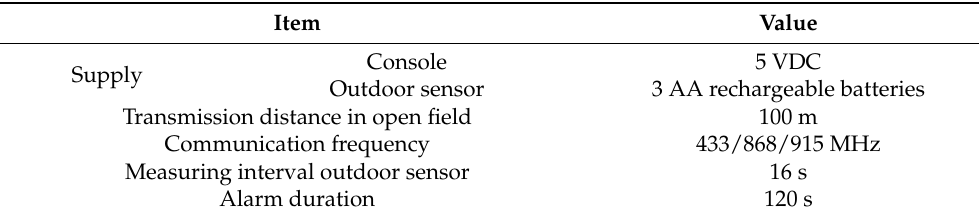
Figure 4. PV panel and weather station. Table 1. Weather station specifications.